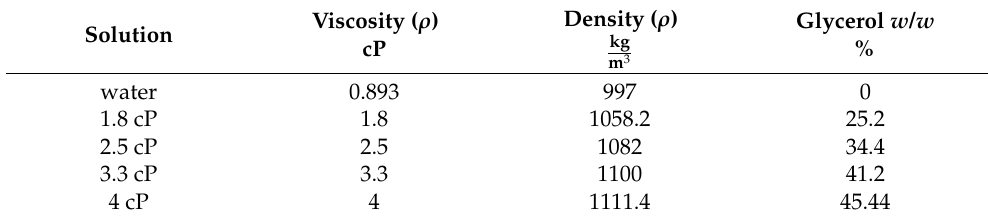
Table 3. Glycerol-water solutions used at 25 ◦ C.